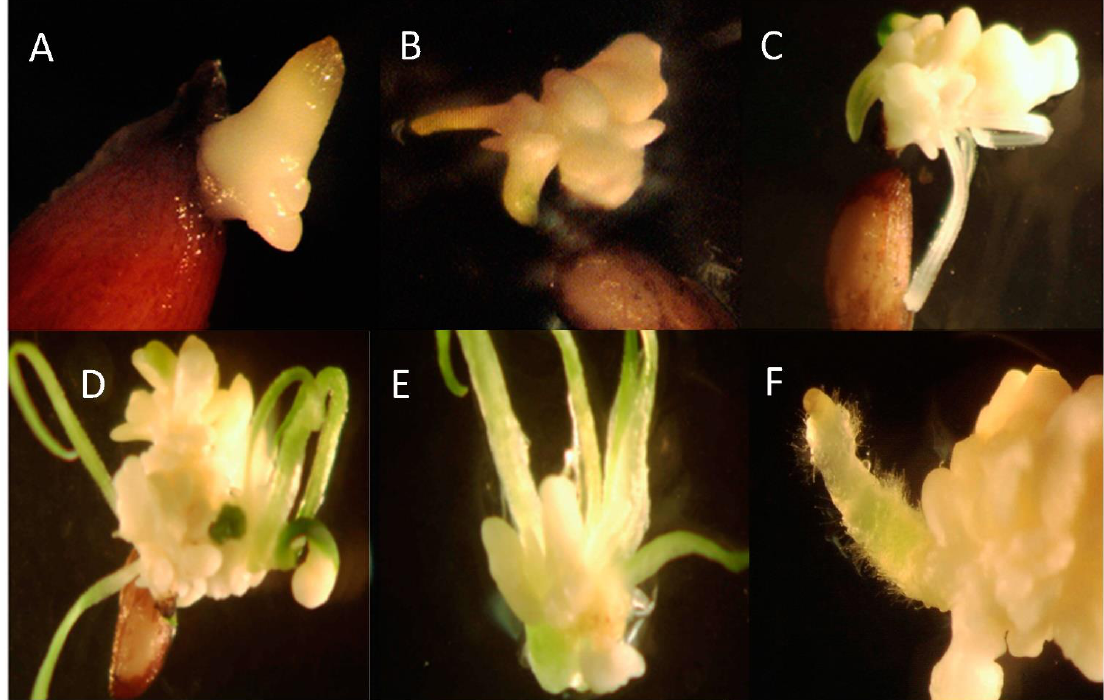
Figure 1. Seed source 1 Xerophyllum asphodeloides germinant from a 4-min H 2 SO 4 scarification treatment. Days after seed began to germinate. ( A ) Day 1, ( B ) Day 26, ( C ) Day 36, ( D ) Day 92, ( E ) Shoot clump 3 weeks after division, ( F ) Emergence of a root from the growing tissue.